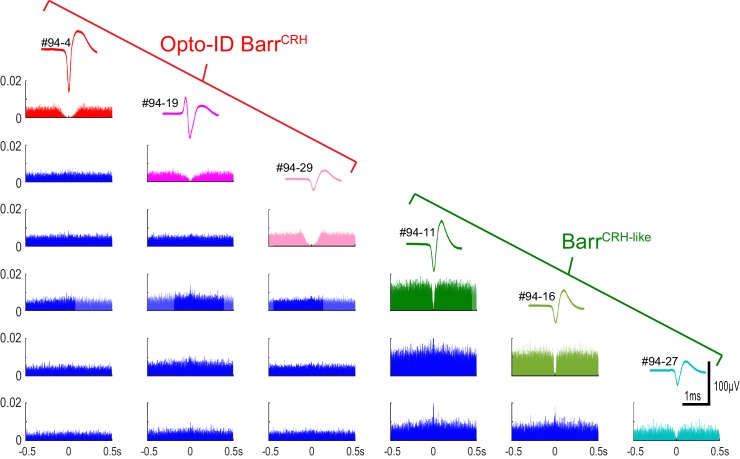
Auto- and cross-correlations of BarrCRH and BarrCRH-like neurons BarrCRH and BarrCRH-like neurons (n = 3 per group) recorded in the same mouse showing their distinct spike waveforms and autocorrelations with a marked central valley feature indicating that they each represent a discriminated unit.The cross-correlations show that several of the units have a short latency cross-correlation indicating that they tended to fire together in synchrony and such cross-correlations were noted both within and between the BarrCRH and BarrCRH-like neuronal groups.